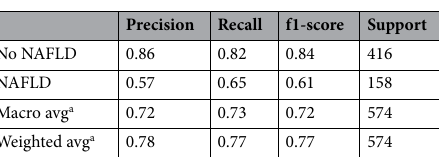
Table 5. Value of precision, recall and F1-score on test set. a avg average.